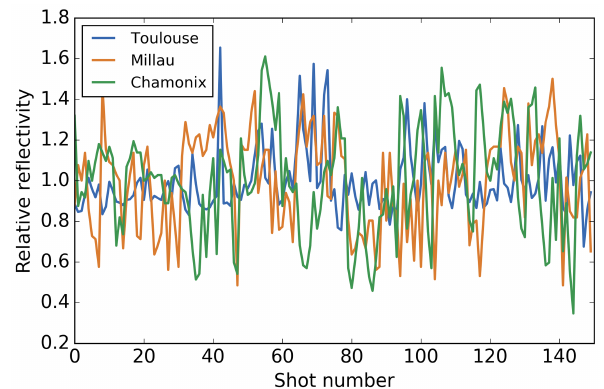
Figure 6. Relative variations of reflectivity of the three scenes from the data set. Toulouse, Millau and Chamonix present medium, high and high) variability, respectively (cf. Table